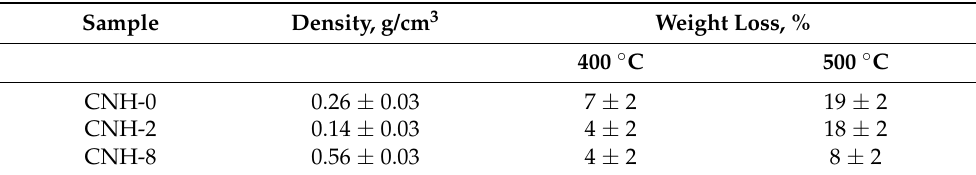
Table 1. Pycnometric density and weight loss of carbon nanohorns (CNHs) after heat treatment at 400 and 500 ◦ C in